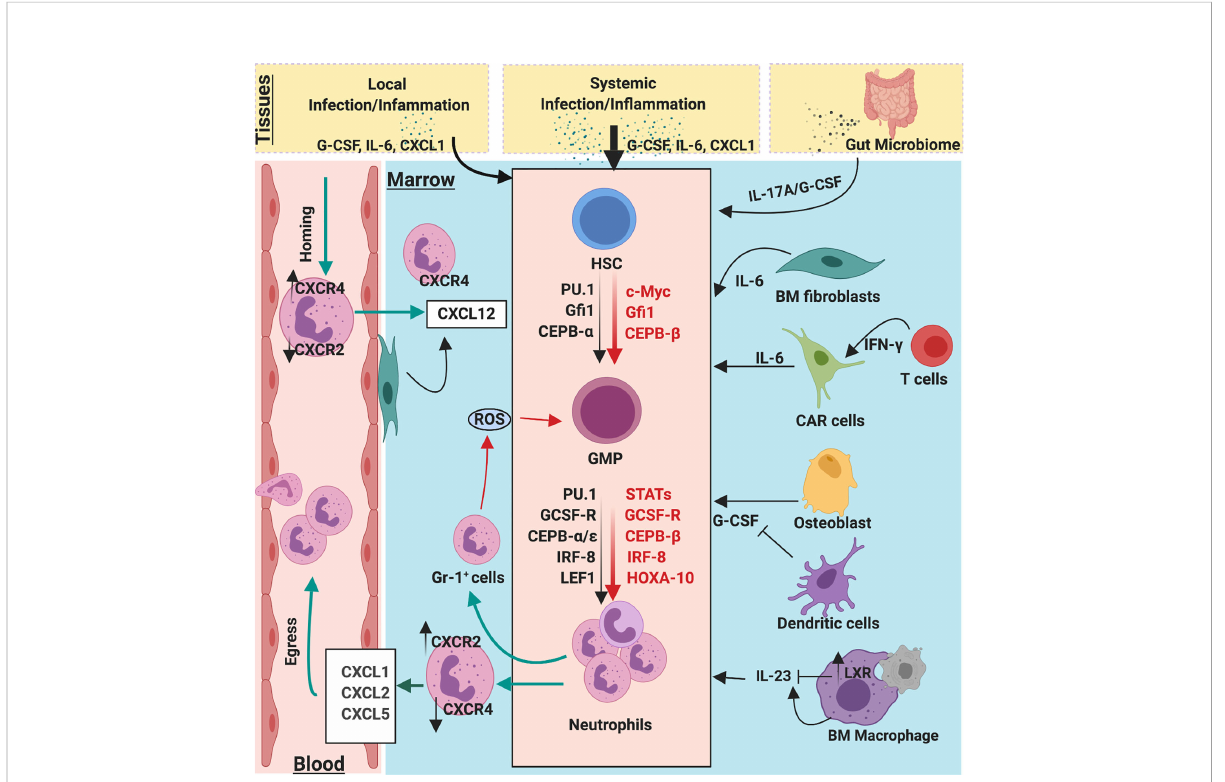
FIGURE 3 Molecular and cellular regulators of emergency and homeostatic granulopoiesis. Granulopoiesis is a tightly regulated process by several molecular and cellular players. During the steady state, C/EBP a is a primary transcription factor that regulates proliferation of neutrophil progenitors by limiting the expression of cell cycle gene such as c-Myc, CDK2, and CDK4. However, during emergency granulopoiesis, C/EBP b directly replaces C/EBP a at the MYC promoter and expedites c-Myc expression to enhance the generation of neutrophils. Robust C/EBP b activity relies on strong activation of JAK/STAT pathways by G-CSF, which is massively released during infection/in fl ammation. During steady state, clearance of apoptotic neutrophils by macrophages activates LXR expression, which downregulates IL-23 secretion, thereby limiting the activity of G-CSF/IL-17A. Bone marrow stromal fi broblast and CXCL12 abundance reticular (CAR) cells also secrete IL-6 which regulate granulopoiesis. Additionally, ROS release from BM GR-1 + cells also regulate proliferation and differentiation of GMPs into neutrophil lineages. Gut microbiome provides PAMPs to activate and regulate steady-state and emergency granulopoiesis through the IL-23/G-CSF/IL-17A